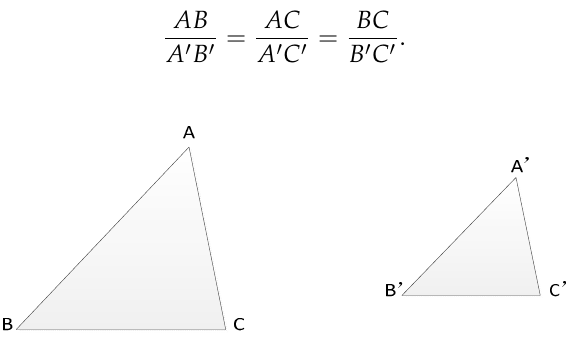
Figure 7. The principle of homothetic triangle.